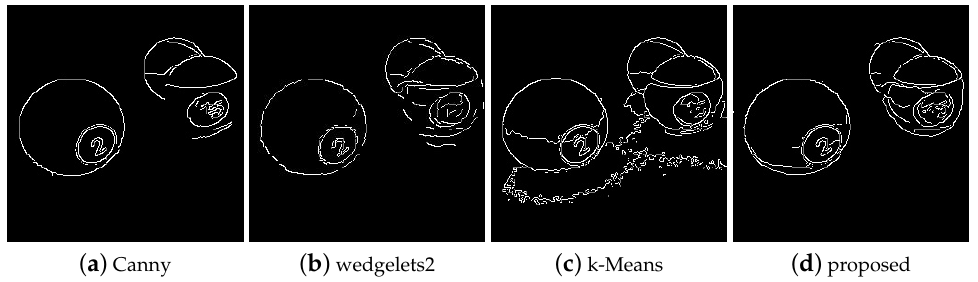
Figure 9. The results of edge detection by different methods: ( a ) Canny, ( b ) wedgelets2, ( c ) k-Means, ( d ) local k-Means (proposed).